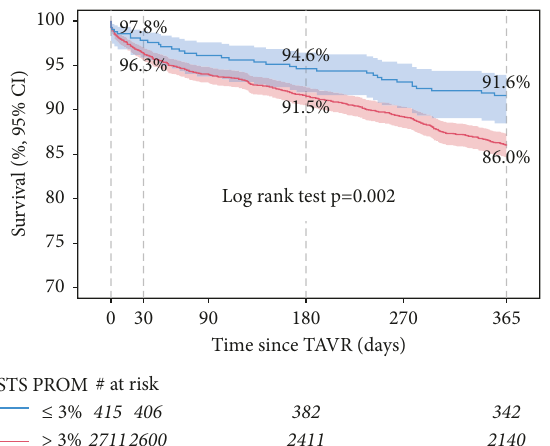
Figure 3: Survival after transcatheter aortic valve replacement surgery in patients with STS PROM